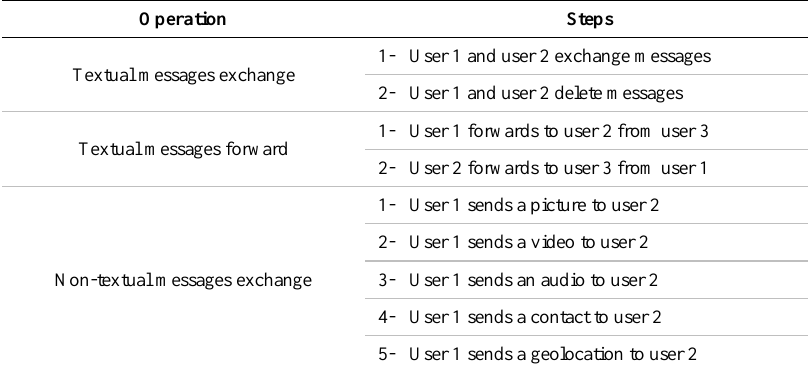
Table 2. Experiments concerning all the types of messages exchanged privately